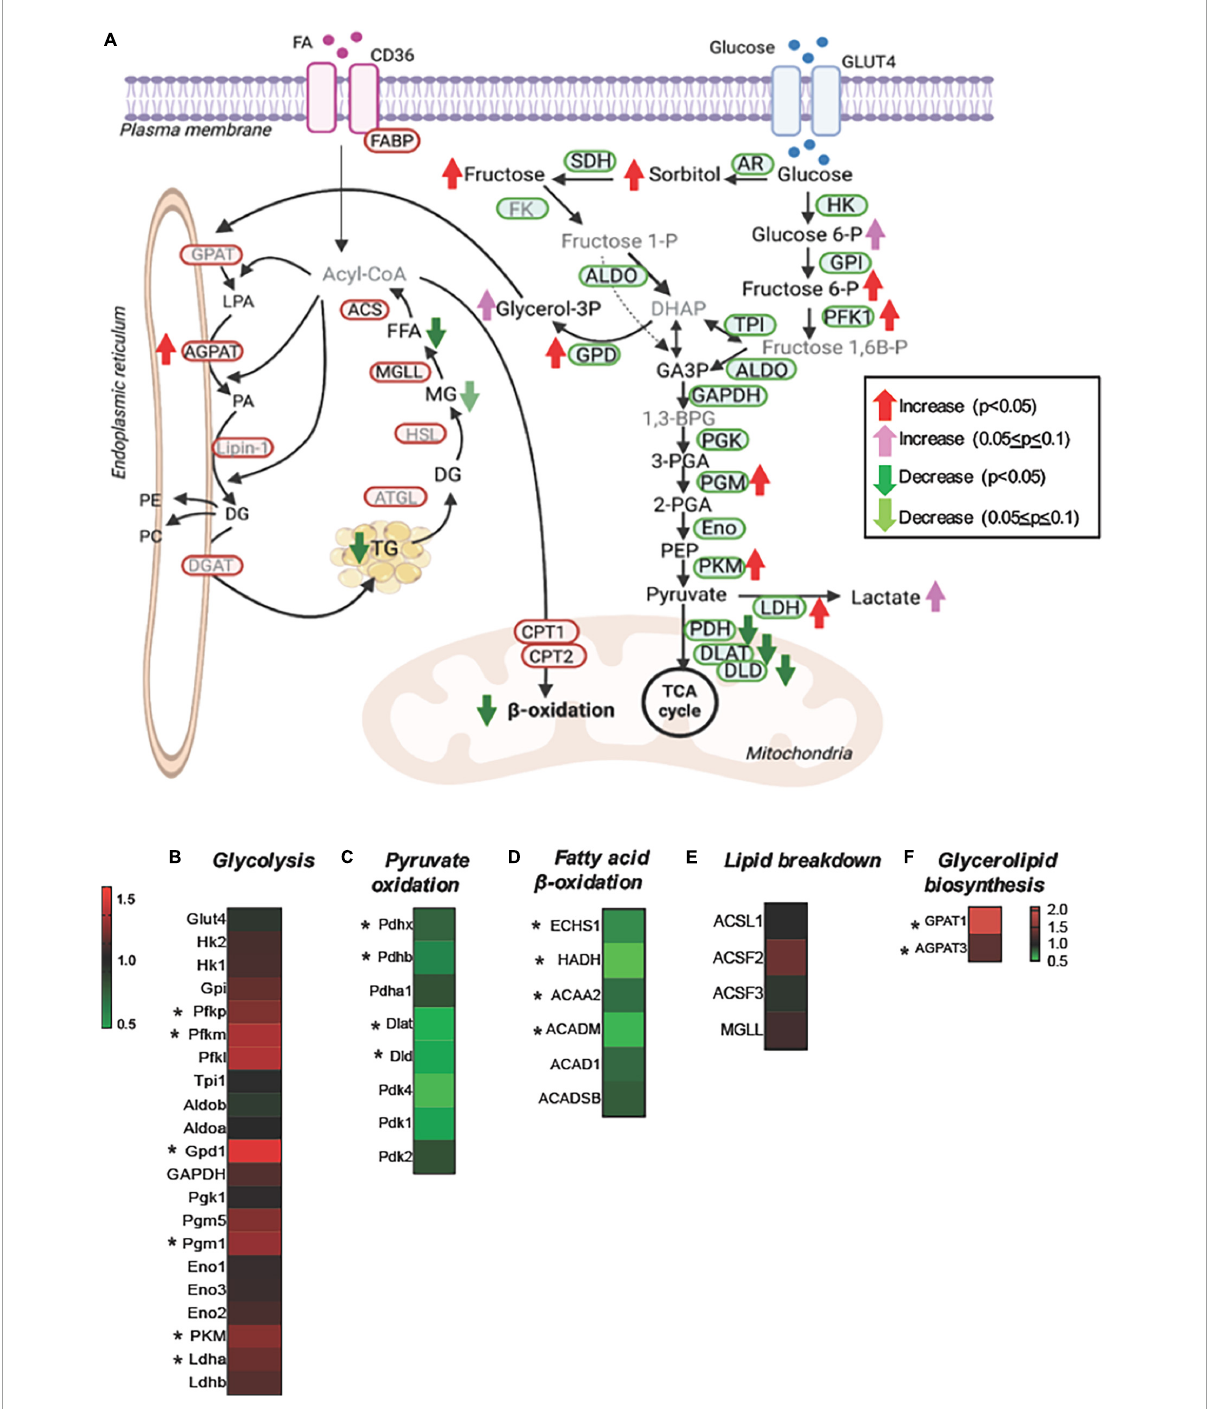
FIGURE5 Integrated metabolomic and lipidomic analyses with proteomic data of Perm1 − / − hearts. (A) Schematics of glucose and lipid metabolism pathways, in which the altered levels of metabolites, lipids, and proteins are indicated by arrows. Detected metabolites and proteins are indicated in black fonts, and undetected metabolites and proteins are indicated in gray fonts (created using BioRender). Heat maps of the detected proteins involved in glycolysis (B) , pyruvate oxidation (C) , fatty acid β -oxidation (D) , lipid breakdown (E) , and glycerolipid biosynthesis (F) . Glucose-6-P:glucose-6-phosphate, fructose-6-P:fructose-6-phosphate, fructose-1-P:fructose-1-phosphate, fructose-1,6B-P: fructose-1,6-bisphosphate, DHAP:dihydroxyacetone phosphate, GA3P:glyceraldehyde-3-phosphate, glycerol-3P:glycerol-3-phosphate, 1,3-BPG:1,3-bisphosphoglycerate, 3-PGA:3-phosphoglycerate, 2-PGA:2-phosphoglycerate, PEP, phosphoenolpyruvate; FFA, free fatty acid; MG, monoglyceride; DG, diglyceride; LPA, lysophosphatidate; PA, phosphatidate; PE, phosphatidylethanolamine; PC, phosphatidylcholines. * p <